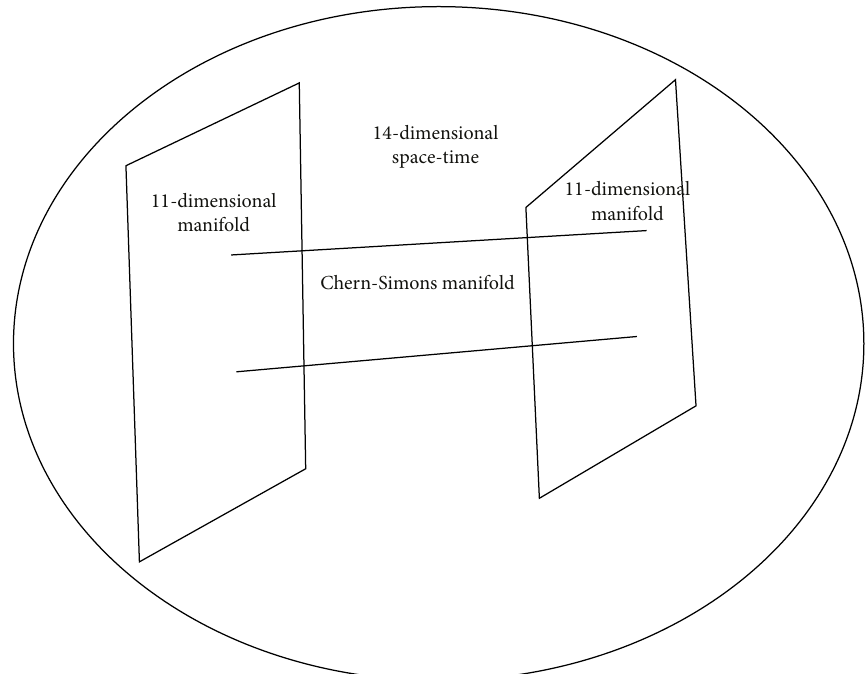
Figure 1: Two eleven-dimensional manifolds + Chern-Simons manifold in 14-dimensional space-time.